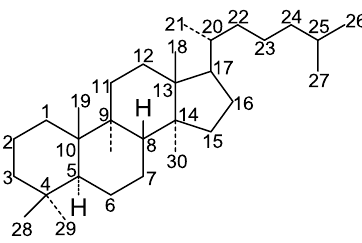
Figure 1. A prototypical lanostane triterpenoid